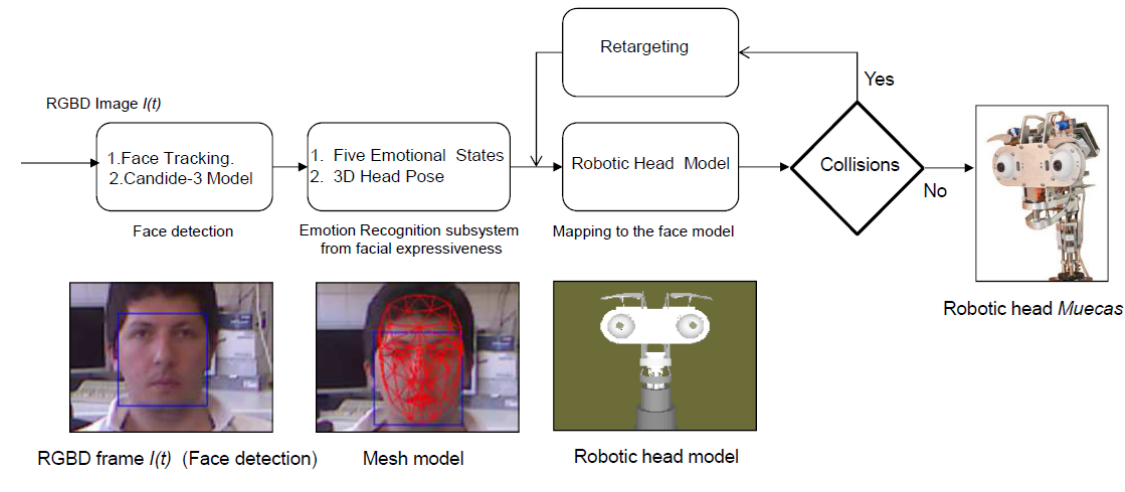
Figure 14. Overview of the imitation system for human-robot interaction (HRI) proposed in this paper.